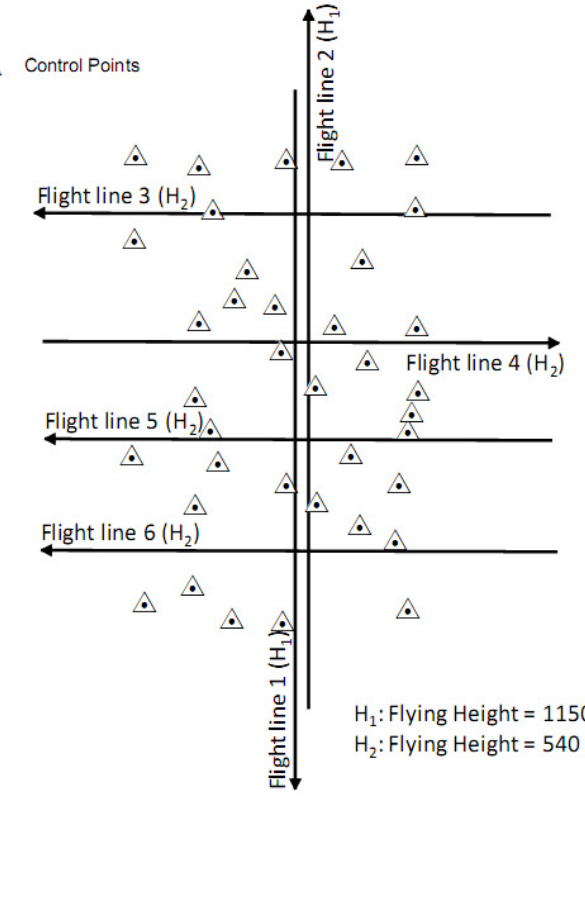
Figure 3. Flight and control configuration of the LiDAR